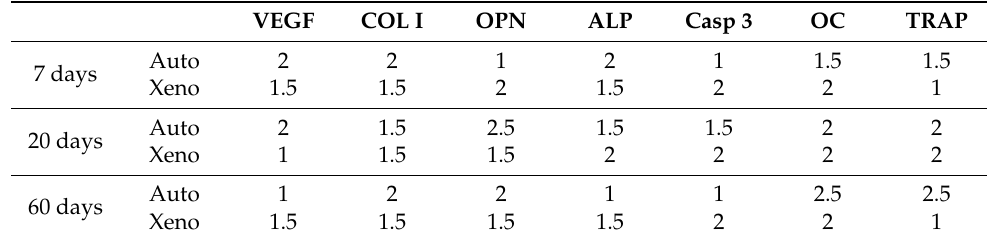
Table 3. Scores obtained for the immunolabeled proteins used in this study. 0: absence; 1: light; 1.5: light to moderate; 2: moderate; 2.5: moderate to intense; 3: